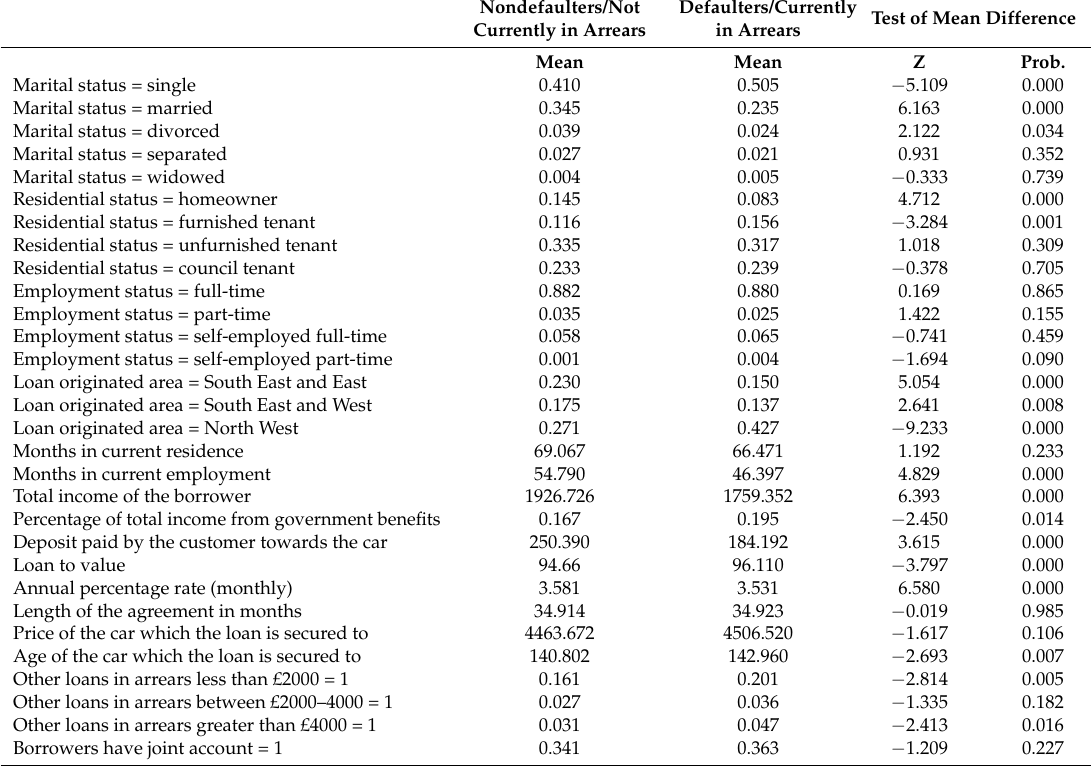
Table 3. Salient feature of defaulters and